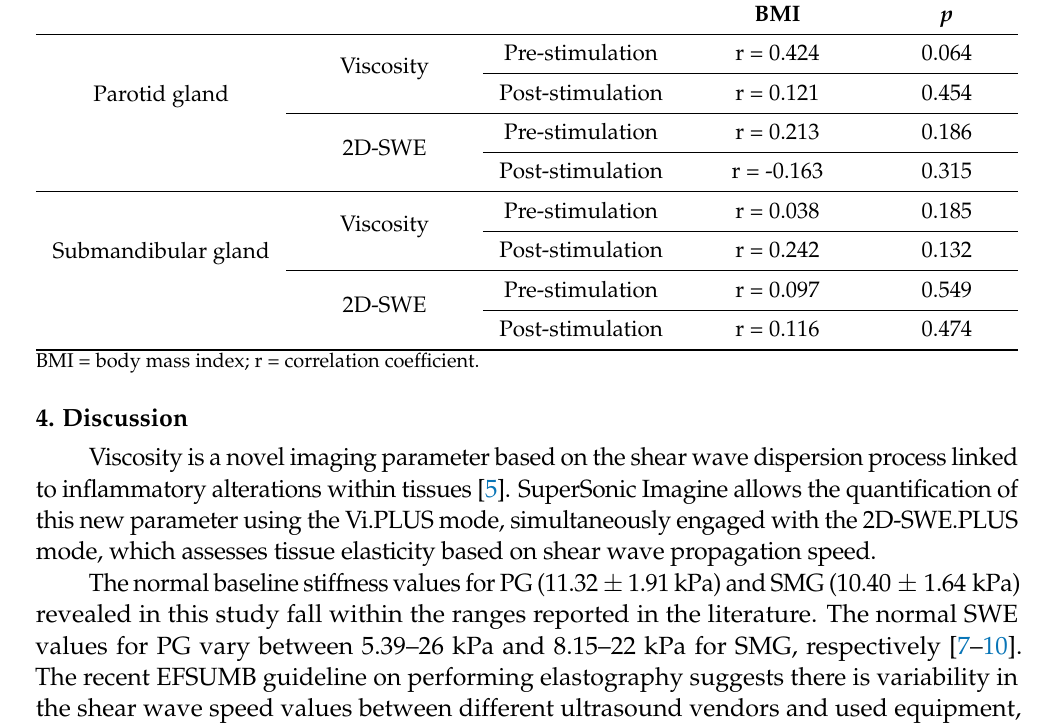
Table 4. Multiple correlations between the body mass index and viscosity and stiffness values of the parotid and submandibular gland, before and after stimulation.